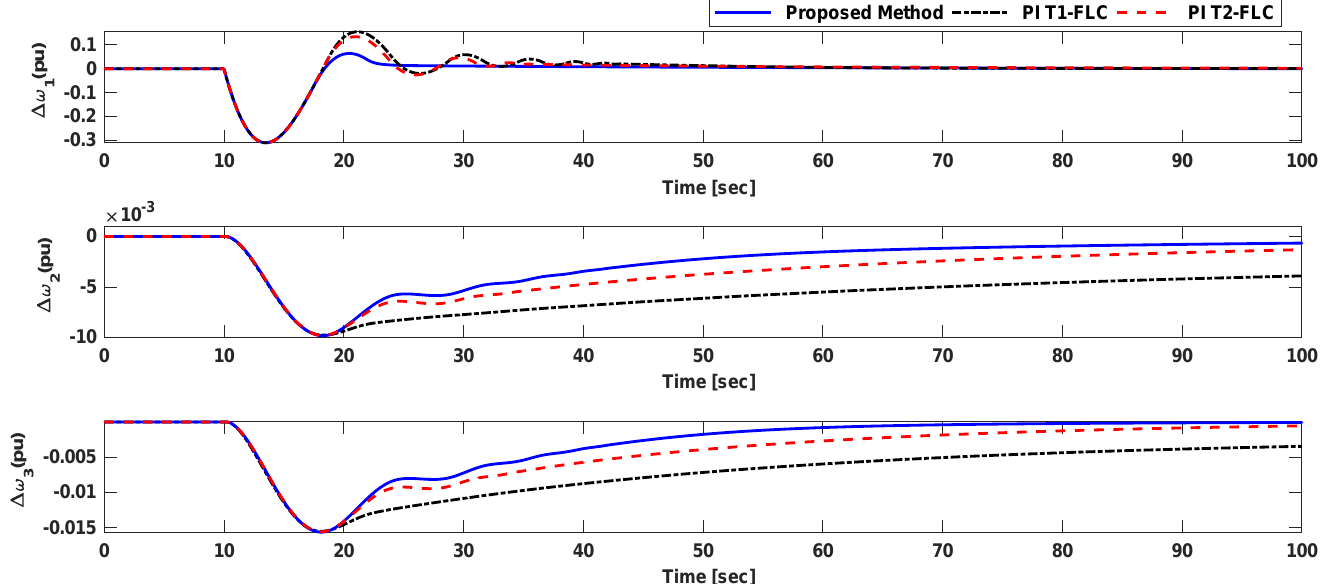
Figure 12. Example 2: Scenario 1: The trajectory of frequency regulation for all three areas.